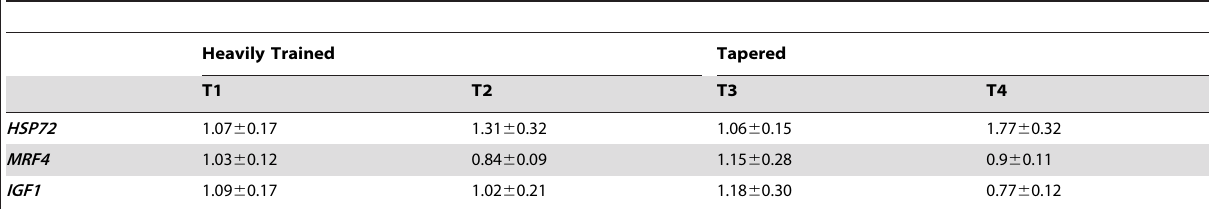
Table 2. Genes not responsive to exercise in MHC IIa fibers in the heavily trained or tapered state.